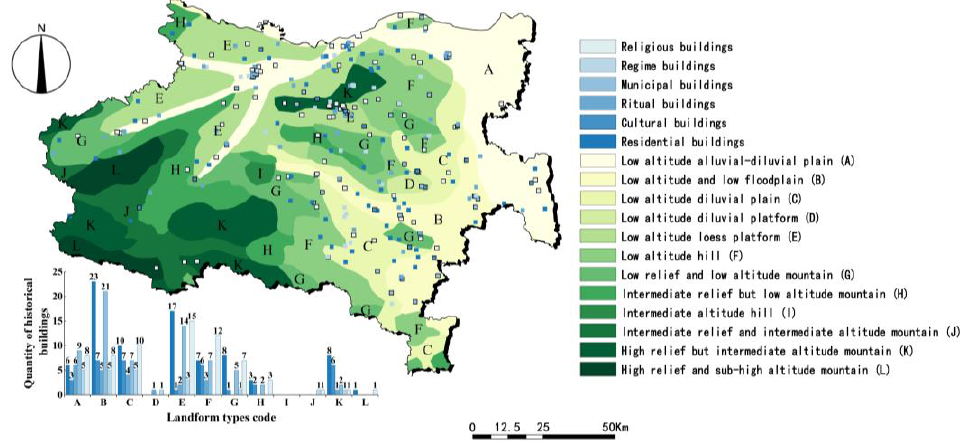
Figure 12. Distribution of various types of historical buildings on different landforms in the Songshan region.